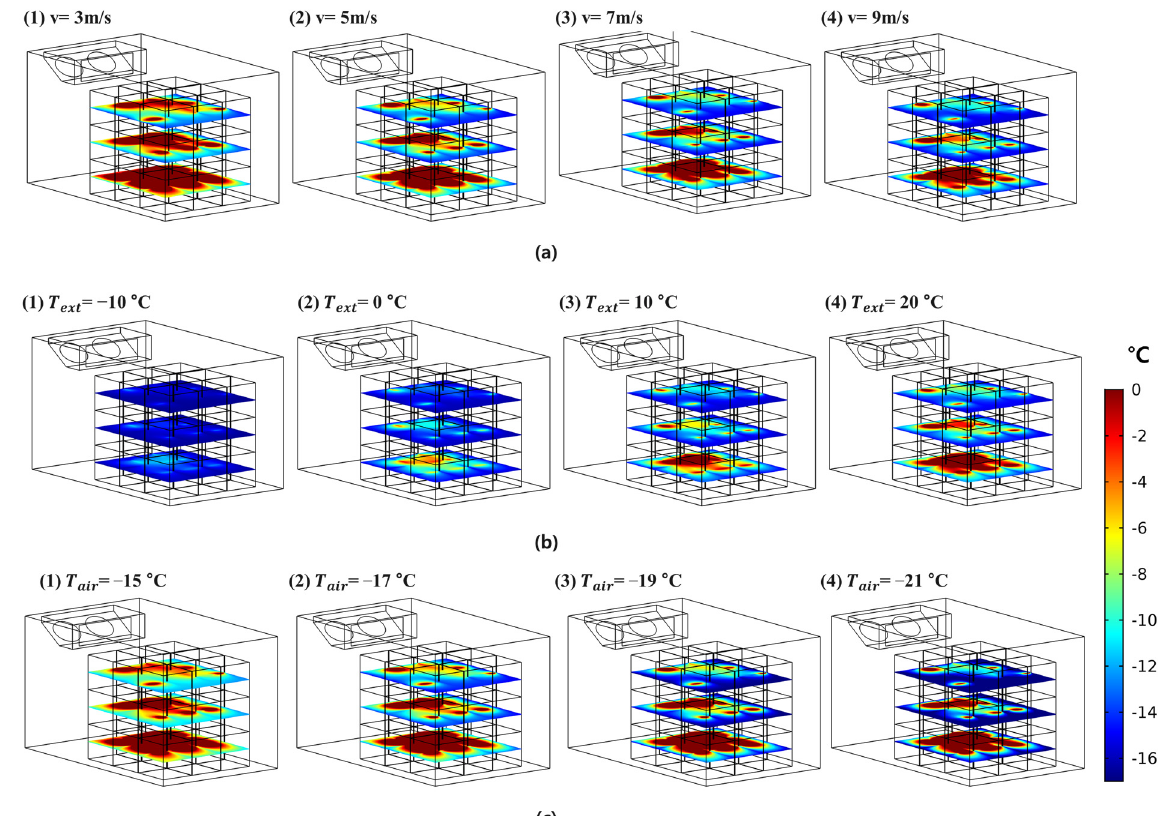
Figure 14. Application of the developed model; evaluation of the influence of experimental conditions; (a) change in sup- ply-air velocity ( v ), (b) change in external temperature ( T ext ), and (c) change in cold air temperature ( T air ).